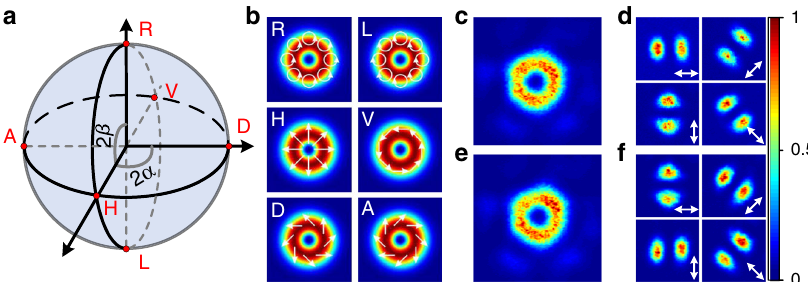
Fig. 5 HOPS beams. a HOPS for the order of l j j = 1. The points on the equator represent spatially variant linearly polarized beams. Particularly, the points H and V represent the radially and azimuthally polarized beam, respectively. The points D and A corresponds to spiral linear polarization states. The poles R and L represent right-handed and left-handed circularly polarized optical vortex beams with opposite handedness of helical phase-front. b Theoretical beam intensity and polarization distributions for the six particular points in a (white arrows indicate the electric fi eld polarization direction). c Experimentally measured radially polarized output beam pro fi le and d , two lobed structure intensity pro fi les when the beam in c passed through a rotated linear polarizer. The two lobes ’ directions are parallel to the transmission axis of the linear polarizer verifying the radial polarization. e , f Experimentally measured azimuthally polarized beam pro fi le and its polarization state, where the two lobes ’ direction is perpendicular to the orientation of the linear polarizer.